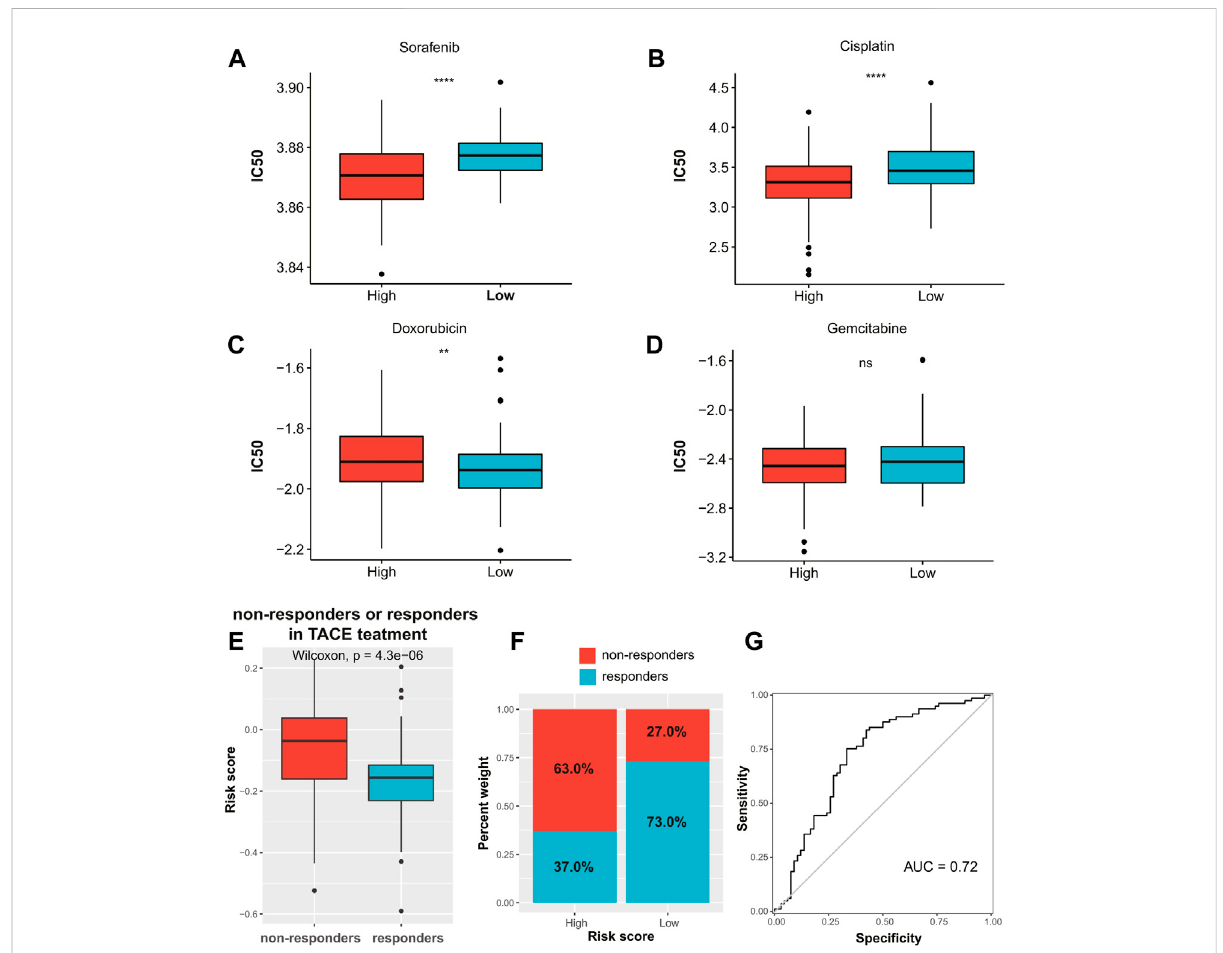
FIGURE 8 Chemotherapy response prediction. The boxplots of the estimated IC 50 for (A) sorafenib, (B) cisplatin, (C) doxorubicin, and (D) gemcitabine in the high- and low-risk groups. (E) Distribution of risk scores among TACE treatment responders and non-responders in the GSE104580 cohort. (F) Proportion of TACE treatment responders or non-responders in the high- and low-risk groups in the GSE104580 cohort. (G) ROC curve of ECM- related signature in predicting TACE response in the GSE104580 cohort. IC 50 , half-maximal inhibitory concentration; TACE, transarterial chemoembolization; ROC, receiver operating characteristic; ECM, extracellular